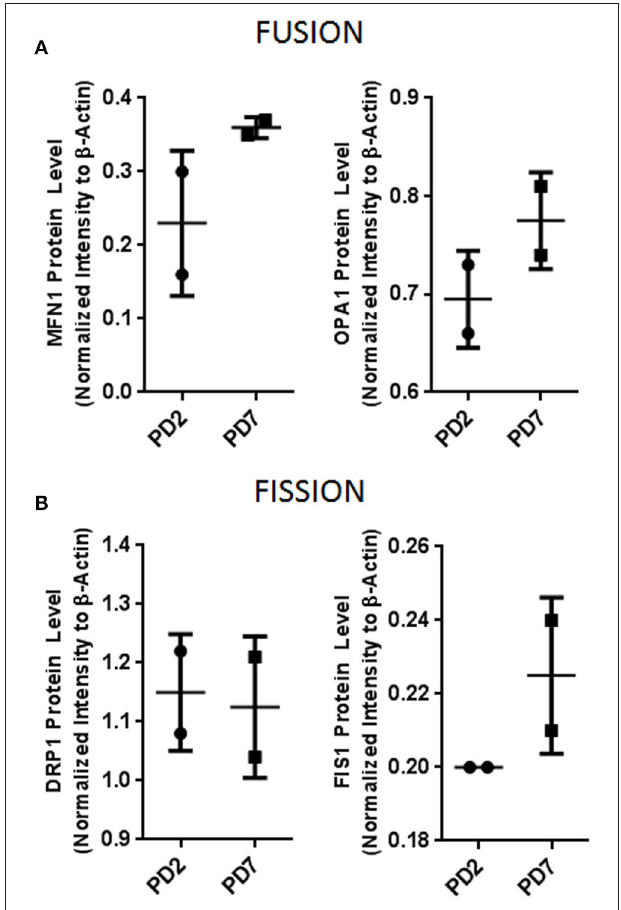
FIGURE 4 | Mitochondrial dynamics protein evaluation. (A) Mitochondrial fusion proteins MFN1 and OPA1. (B) Mitochondrial fission proteins DRP1 and FIS1. Bar graphs depict protein expression as an arbitrary unit when protein of interest was normalized to β -actin. MFN1, Mitofusion1; OPA1, Optic atrophy 1; DRP1, Dynamin-1-like protein; FIS1, Mitochondrial fission 1.